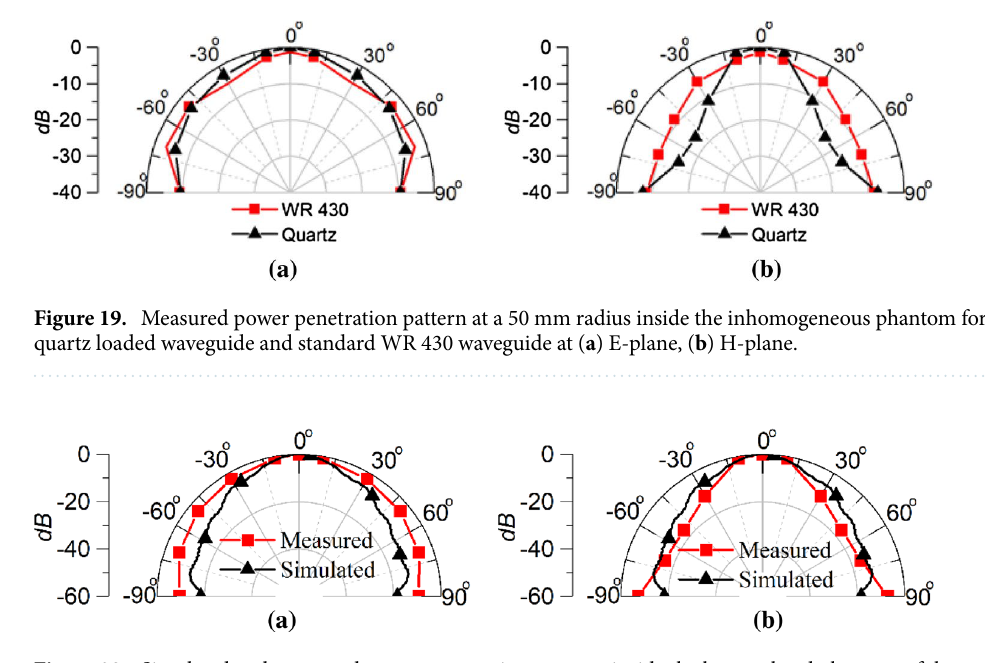
Figure 20. Simulated and measured power penetration patterns inside the human head phantom of the open- ended quartz loaded waveguide operating at 2.45 GHz ( a ) E-plane, ( b )